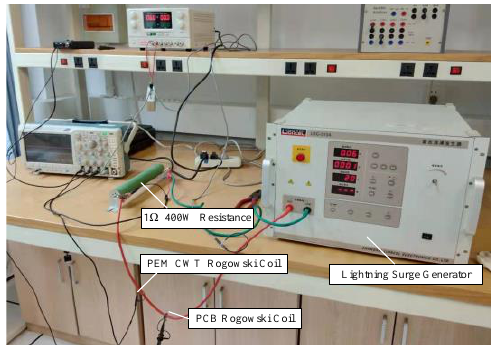
Figure 12. Scene of the lightning surge test.